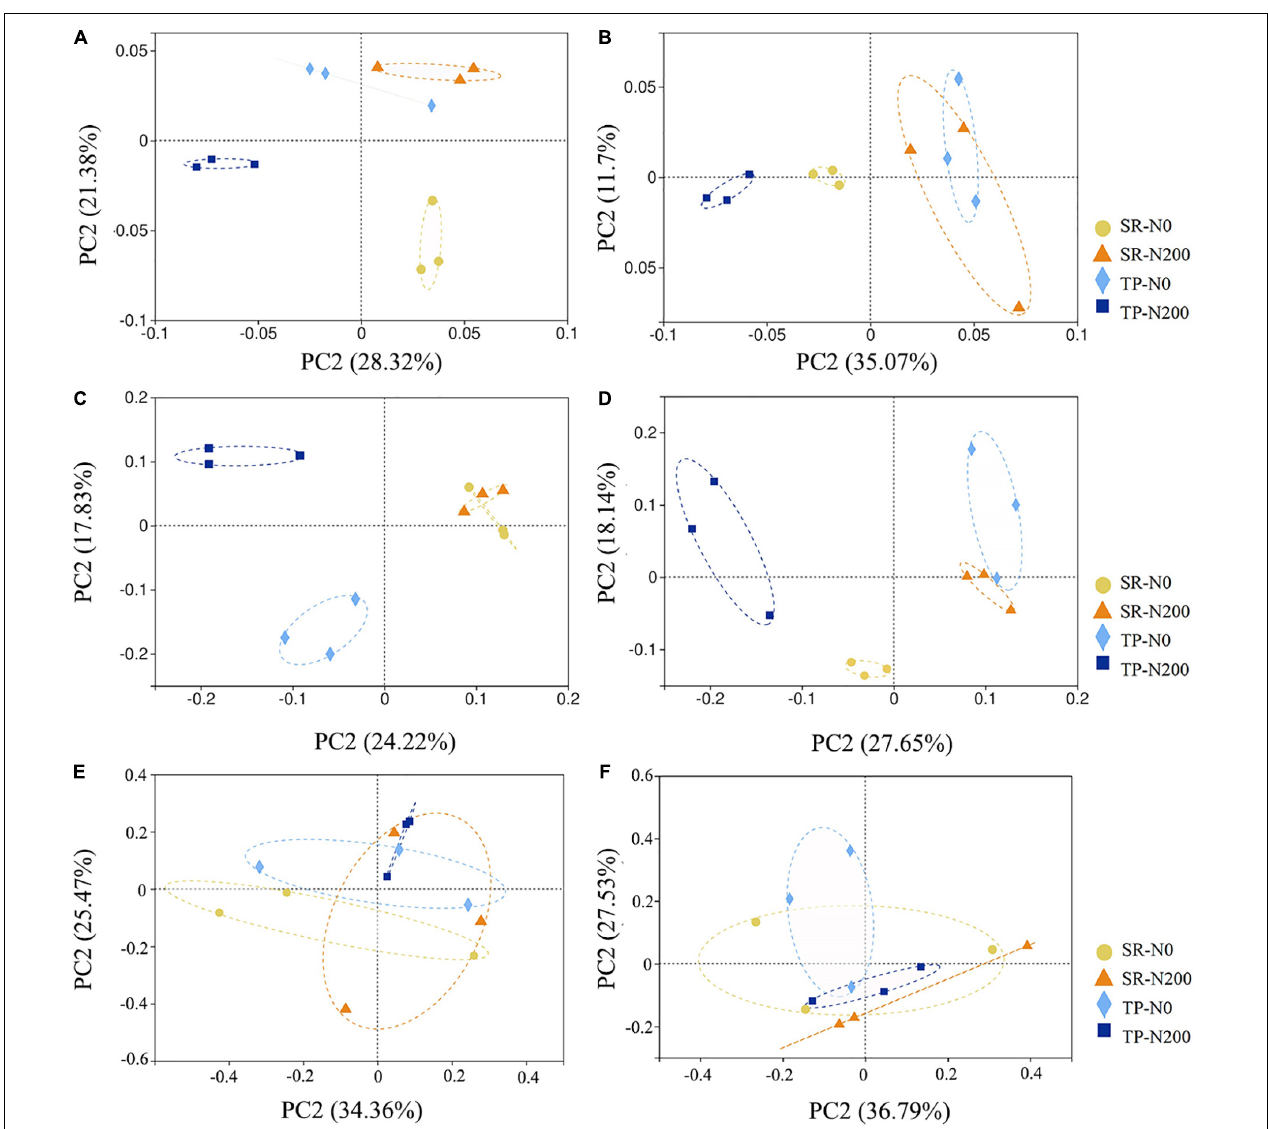
FIGURE 2 | Beta diversities of soil bacterial during spring (A) and autumn (B) , fungal diversity in spring (C) and autumn (D) , and nematode diversity in spring (E) and autumn (F) seasons were analyzed by principal coordinates analysis (PCoA) based on unweighted Unifrac phylogenetic distance metrics at the OTU level and displayed in scatter diagram, each treatment with three replications. SR-N0 = straw returning without N fertilizer application; SR-N200 = straw returning with 200 kg ha − 1 N fertilizer application; TP-N0 = traditional planting without N fertilizer application; TP-N200 = traditional planting with 200 kg/ha nitrogen fertilizer